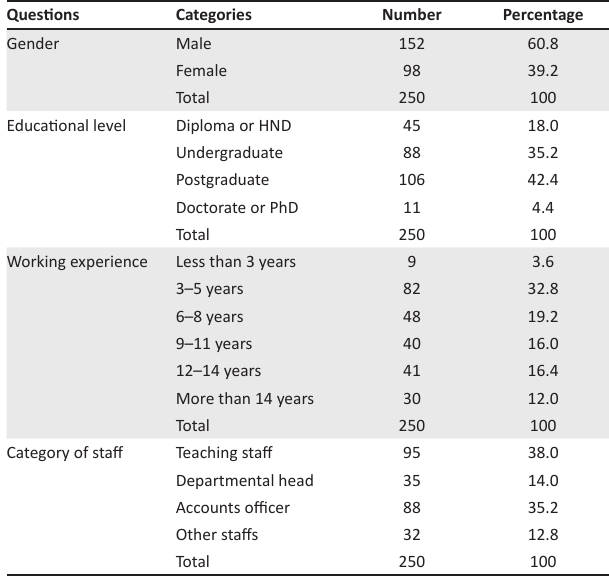
TABLE 1: Demographic data of